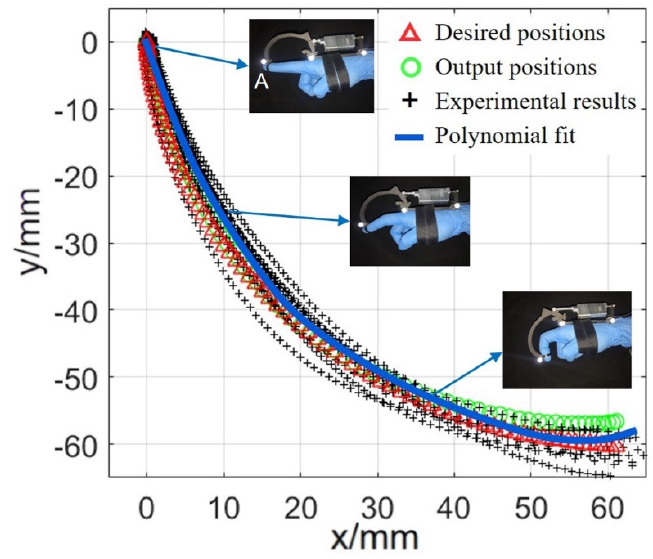
Figure 15. Motion performance verification of the exoskeleton.